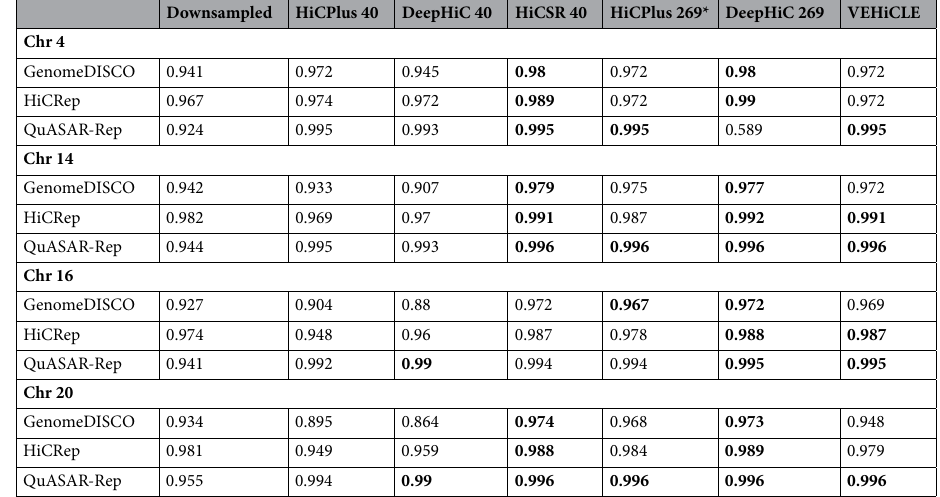
Table 2. Comparison of Hi-C superresolution algorithms using Hi-C reproducibility metrics. Networks are trained using the training set chromosomes of the GM12878 cell line and evaluated on the test chromosome set of the GM12878 cell line. Top 2 scores for each metric are bolded. *Our version of the HiCSR model with an expanded window size of 269 repeatedly failed to converge using these tools, thus we include only the authors original model for